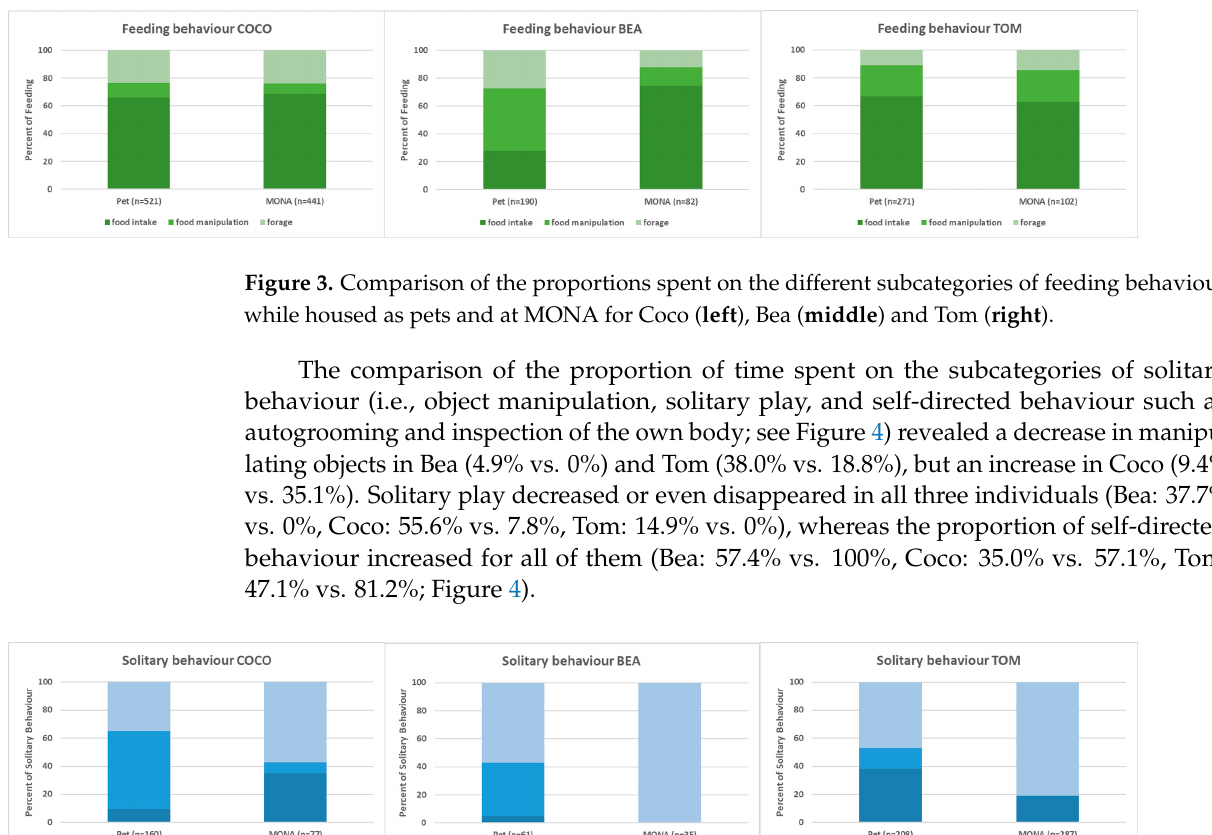
Figure 4. Comparison of the proportions spent on the different subcategories of solitary behaviour while housed as pets and at MONA for Coco ( left ), Bea ( middle ) and Tom ( right ).